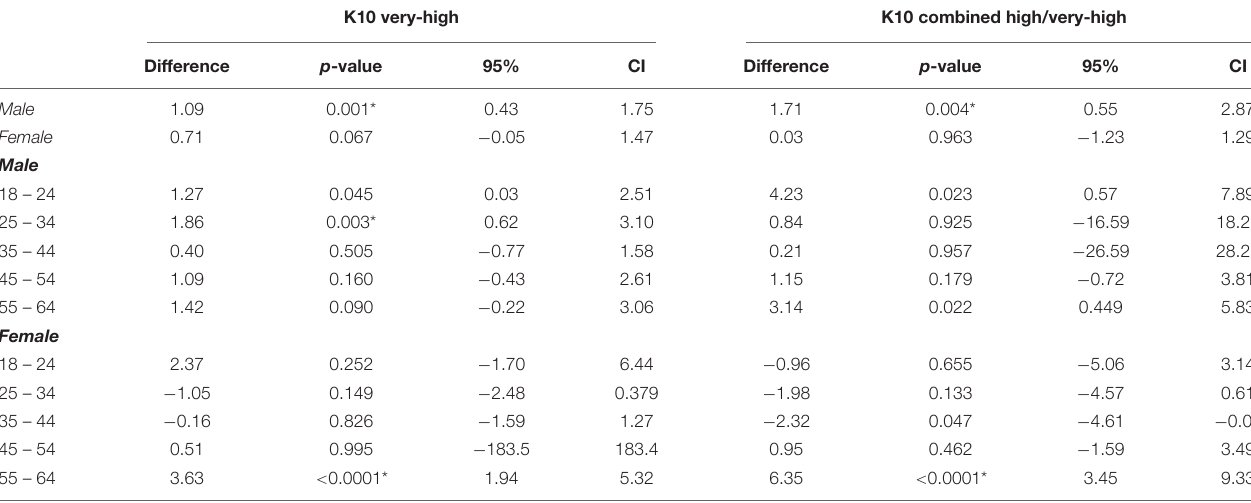
TABLE 3 | Two-sample comparisons of psychological distress rates between the first and the last surveys in 2001 and 2017/19. K10 very-high K10 combined high/very-high Difference p -value 95%